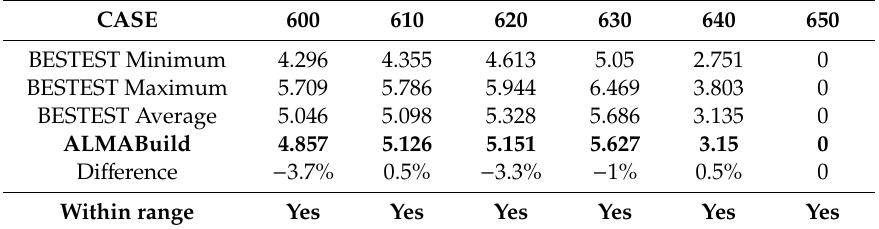
Table 3. Annual Heating Load (MWh) obtained for non-free-float lightweight BESTEST cases compared with the minimum and maximum threshold values indicated by BESTEST.